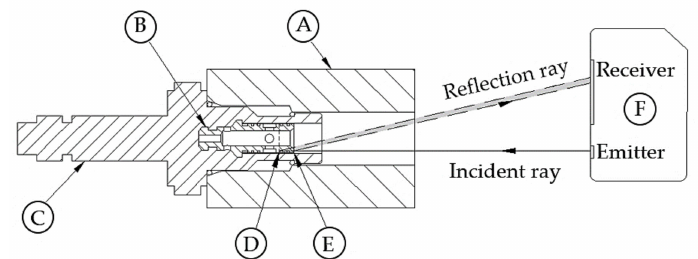
Figure 4. Principle of valve spool displacement measurement: A: Valve manifold; B: Spool; C: Iron core (and plunger, which is not shown); D and E: Spool upper and lower limits of travel; and F: Laser triangulation